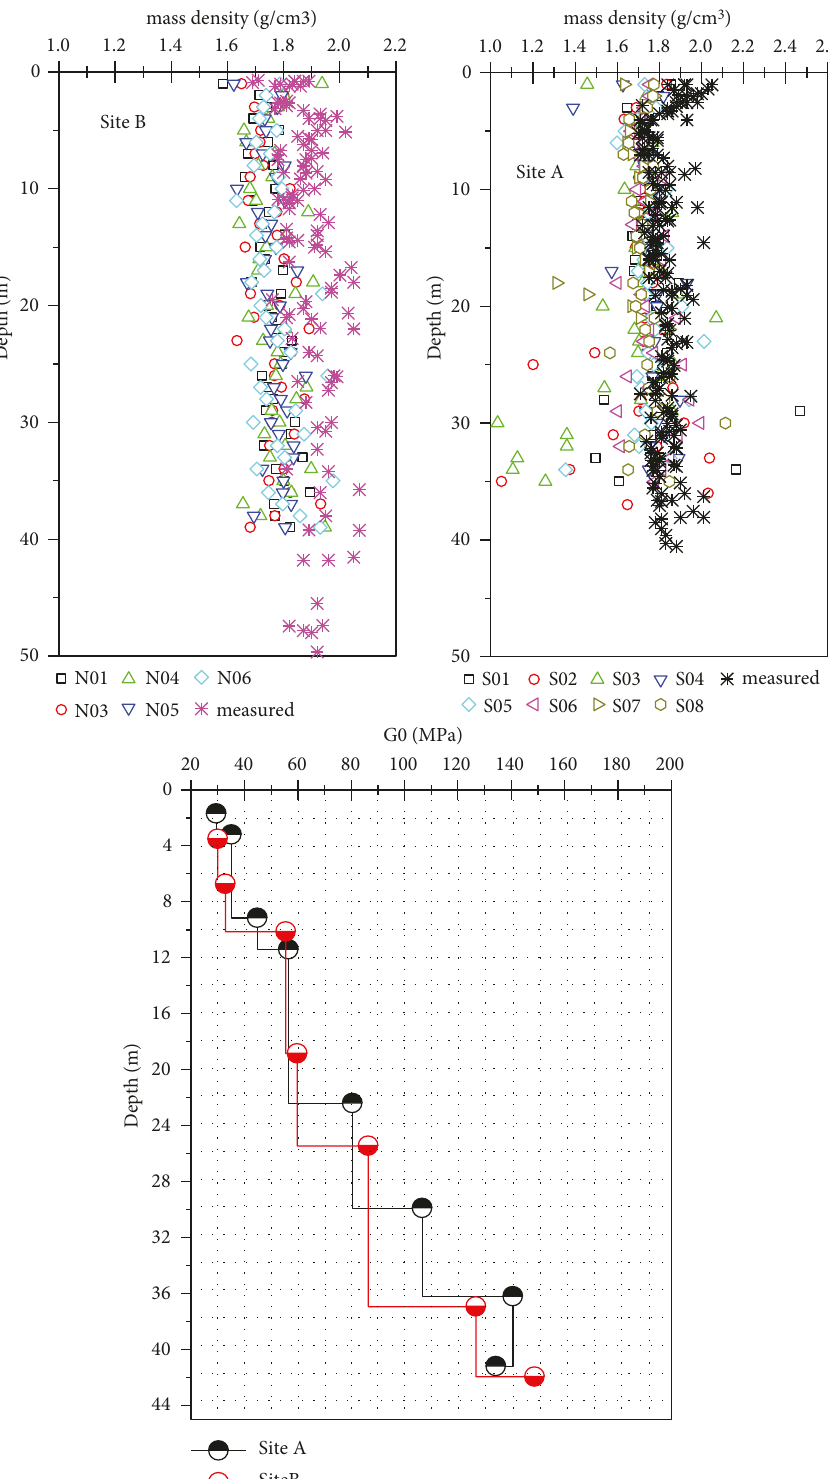
Figure 10: Mass density and initial shear modulus profiles at Sites A and